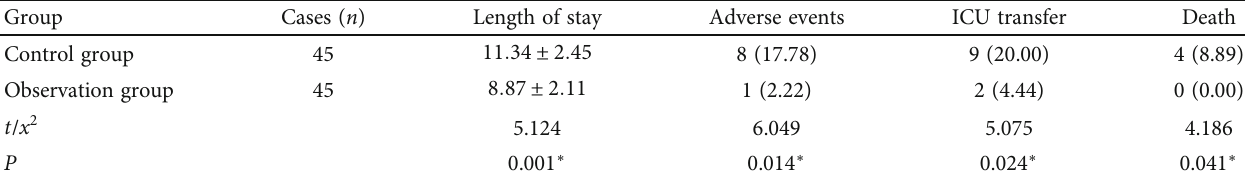
Table 4: Comparison of length of stay, incidence of adverse events, ICU transfer and death in 2 groups (( (cid:1) x ± s ), n (%)). Group